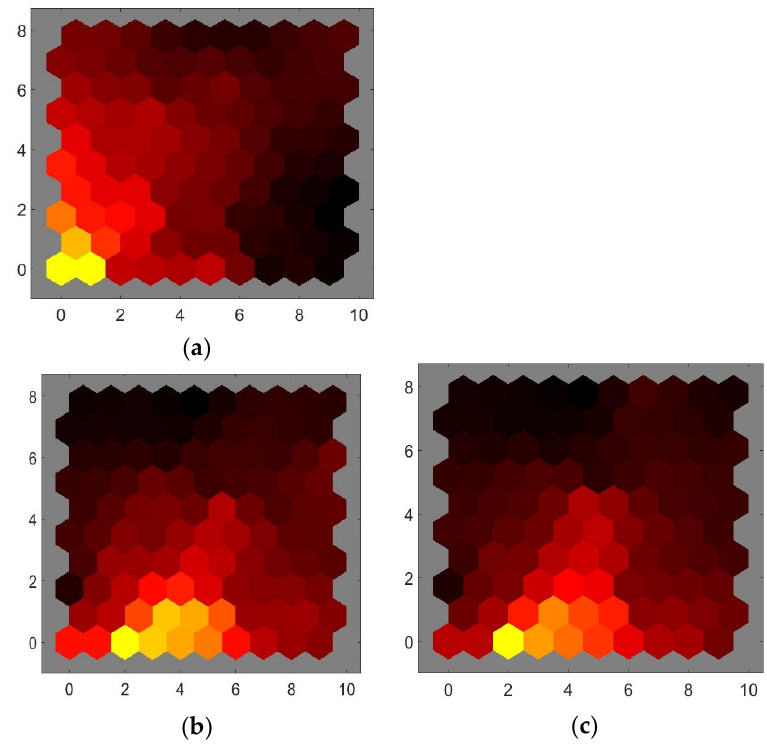
Figure 5. Correlation between the variables using the Kohonen network weight planes. ( a ) RMS position, ( b ) RMS velocity, and ( c ) RMS acceleration respectively. The horizontal and vertical axes are neurons’ positions.